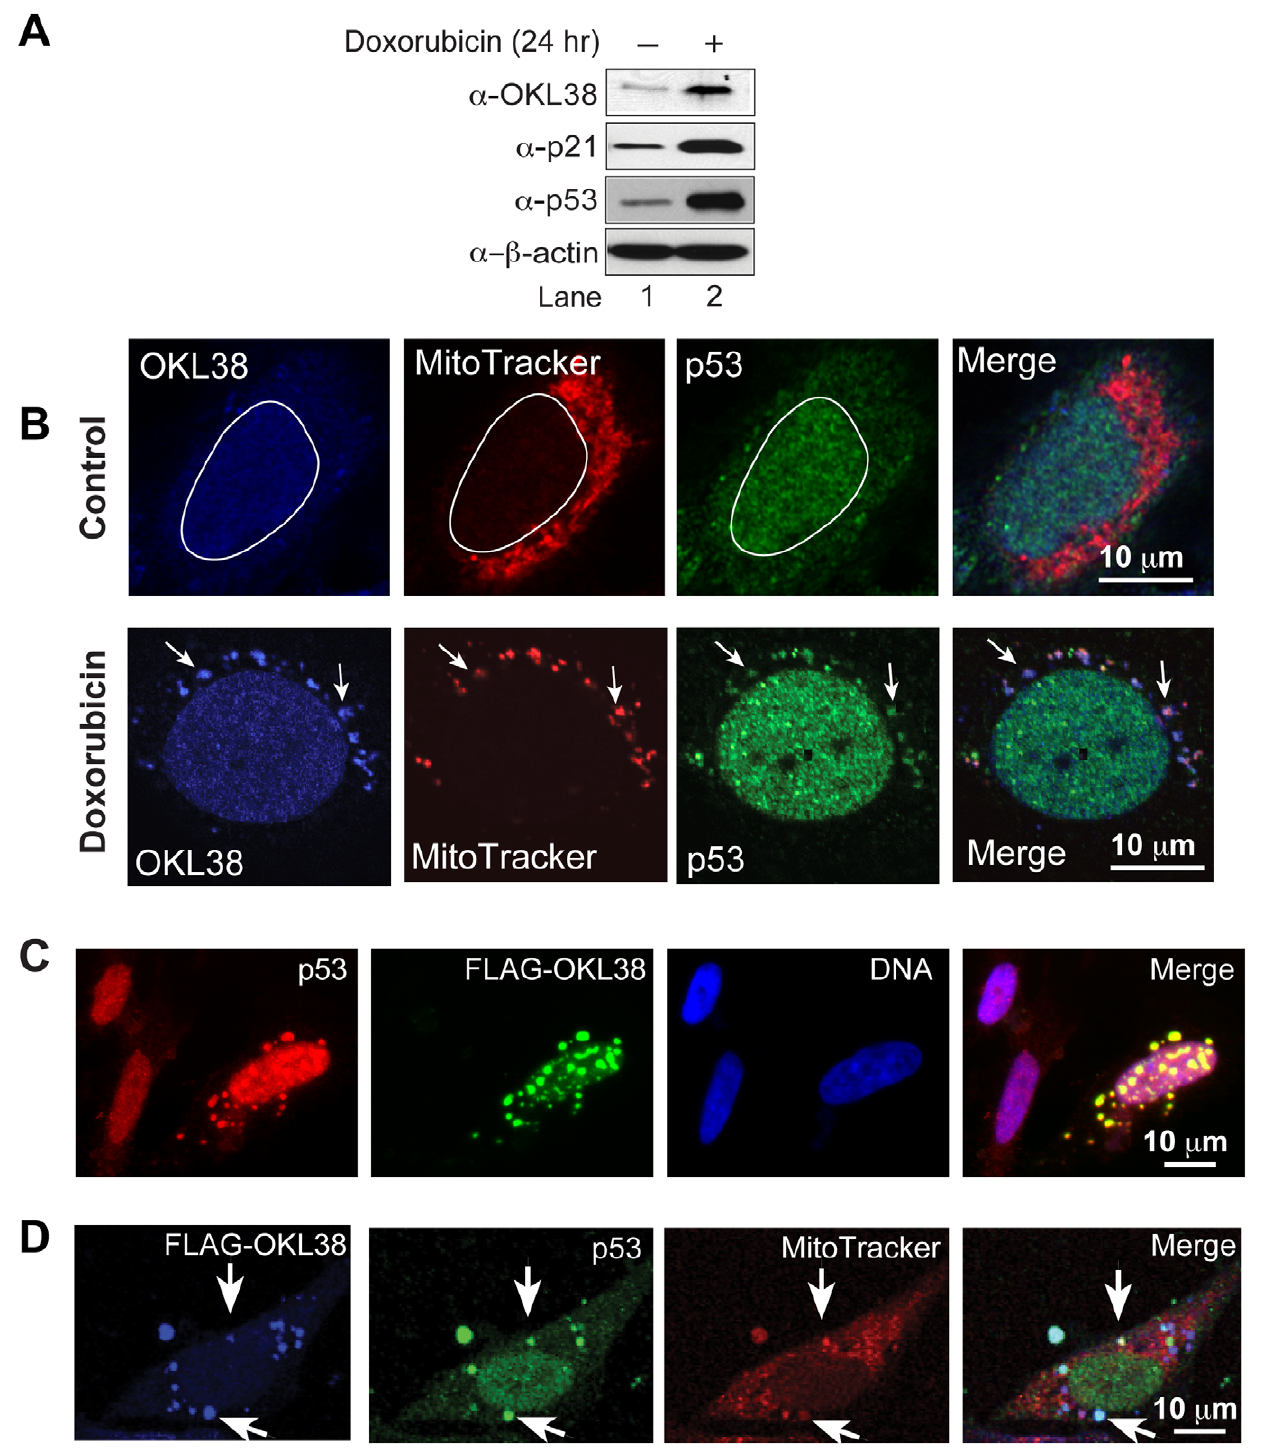
Figure 1. OKL38 and p53 colocalize in mitochondria. (A) Changes in OKL38, p21, and p53 protein levels after doxorubicin treatment were analyzed by Western blot. b -actin was probed as a loading control. (B) Upper panels: before DNA damage, confocal images showed that OKL38 (pseudocolored blue) and p53 (green) were enriched in the nucleus outlined with a irregular white circle in U2OS cells. Lower panels: after DNA damage by doxorubicin, both OKL38 (blue) and p53 (green) were detected in mitochondria stained by the MitoTracker Red dye. Arrows denote the mitochondria spots with OKL38 and p53 staining. (C) Fluorescent microscopy images showed that p53 (red) and OKL38 (green) colocalized in large speckles outside of nucleus (DNA staining in blue). (D) Confocal images showed that FLAG-OKL38 (blue) and p53 (green) colocalized with mitochondria (red) after FLAG-OKL38 overexpression in U2OS cells. Arrows denote the large mitochondria speckles with both FLAG-OKL38 and p53 localization.